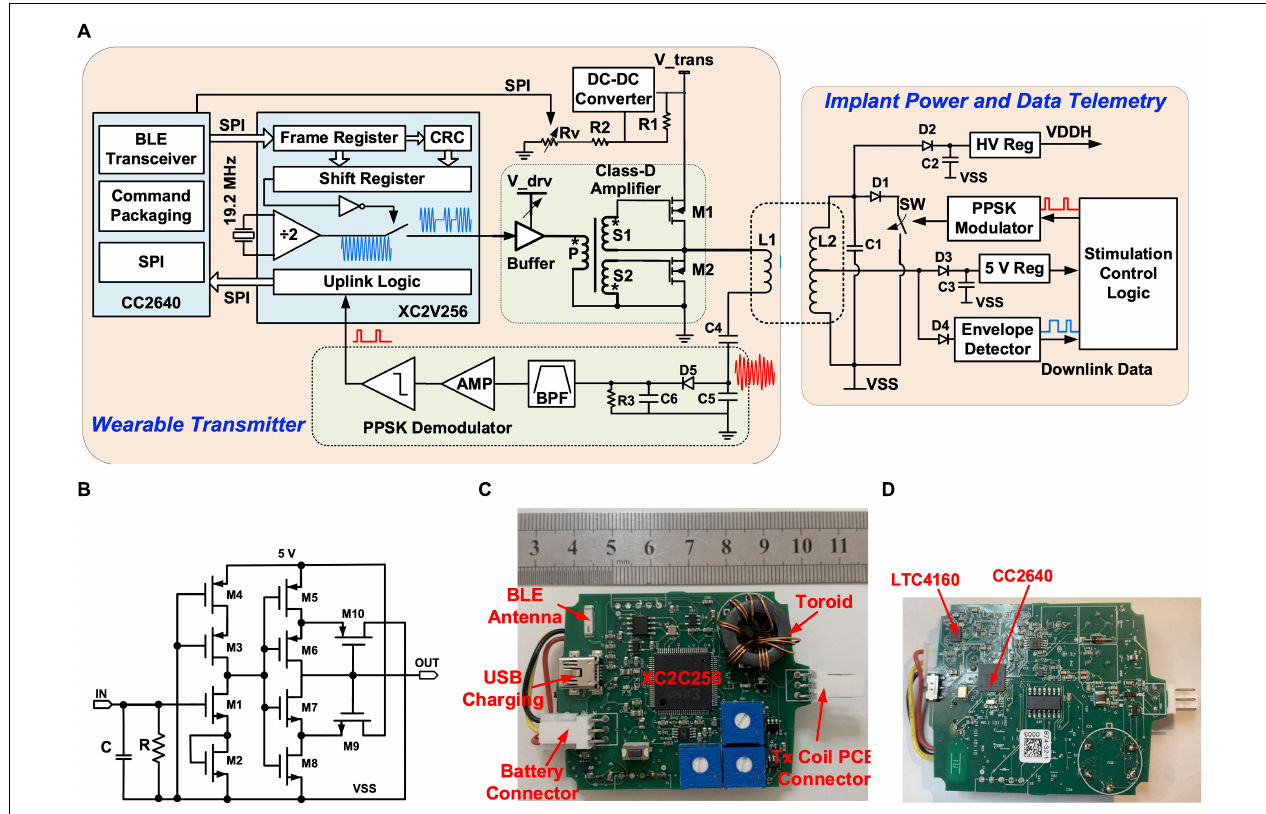
FIGURE 3 | Stimulator circuits: (A) Schematic of the power and data telemetry; (B) Schematic of the integrated OOK demodulator; (C) Photo of the top side of the wearable transmitter; (D) Photo of the bottom side of the wearable transmitter.